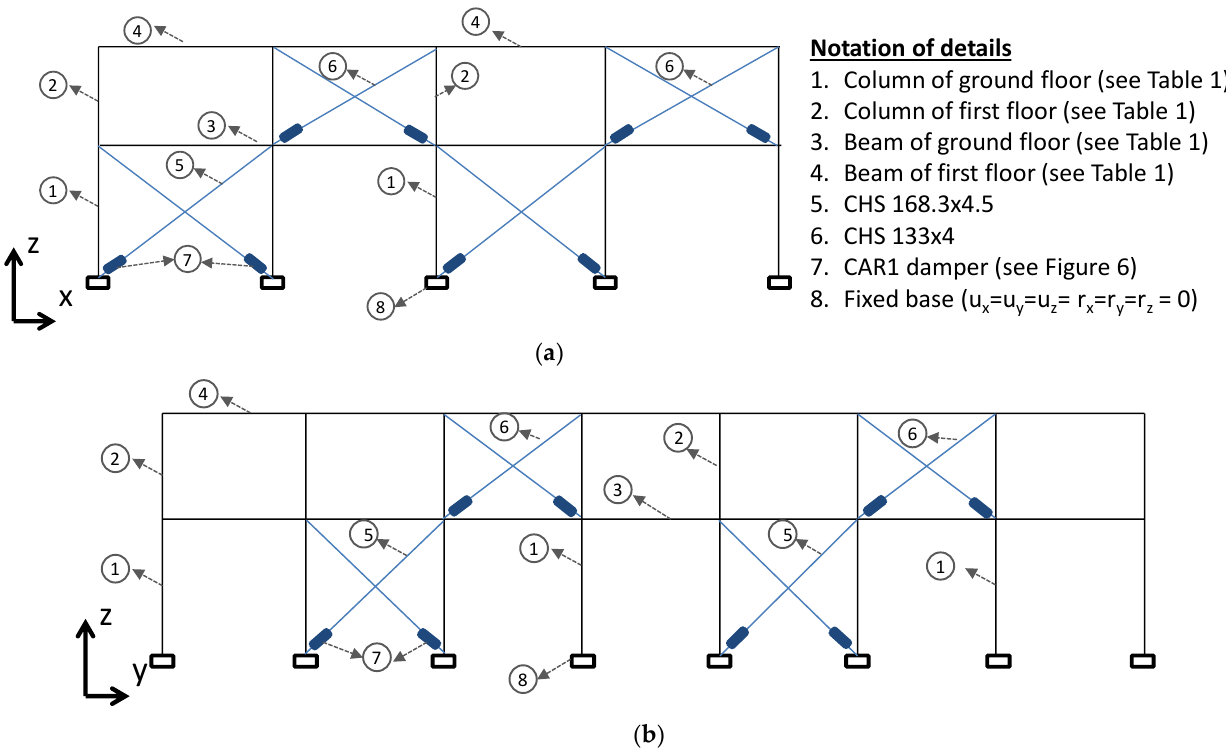
Figure 7. Redesign of building BM2 ( a ) x-x direction; ( b ) y-y direction. 243